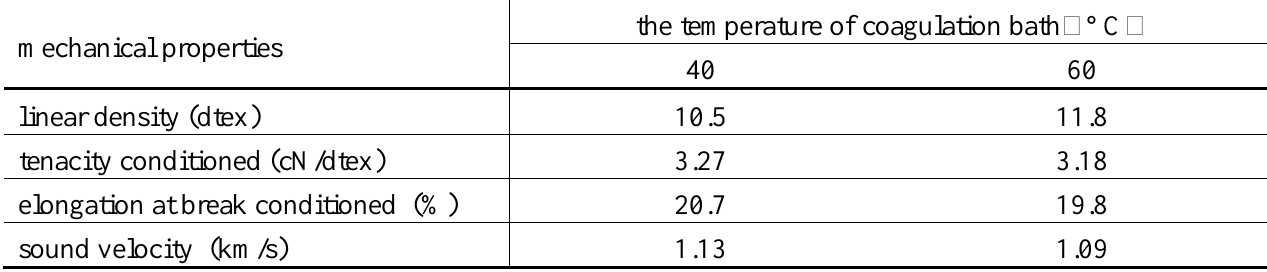
Table 3. Effect of the temperature of coagulation bath on Mechanical properties of as-spun